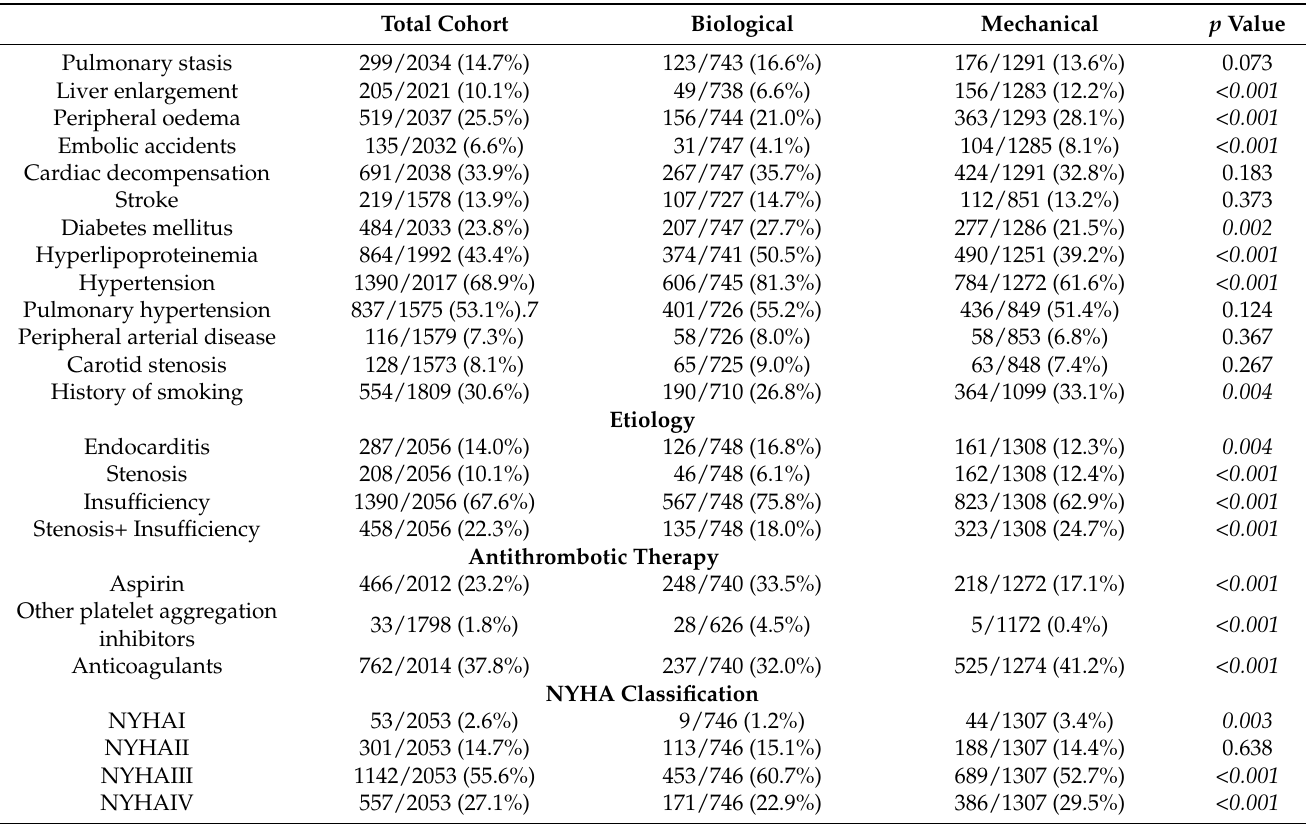
Table 1. Preoperative